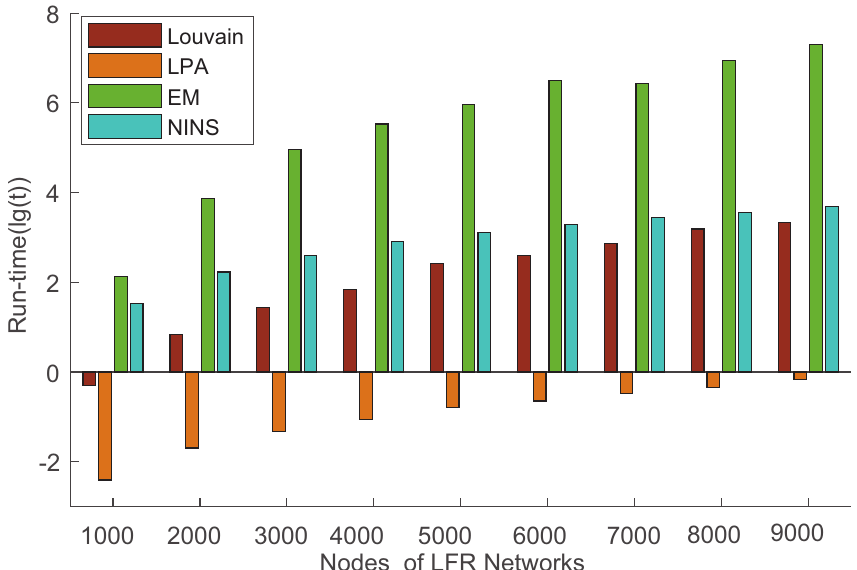
Figure 8. The runtime of NINS and three classic algorithms in LFR